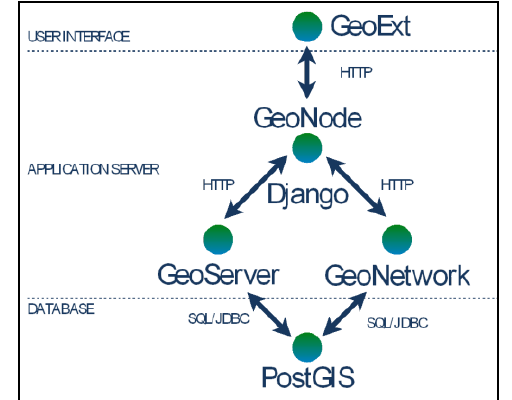
Figure 4. Schema of the MASDAP-GeoNode